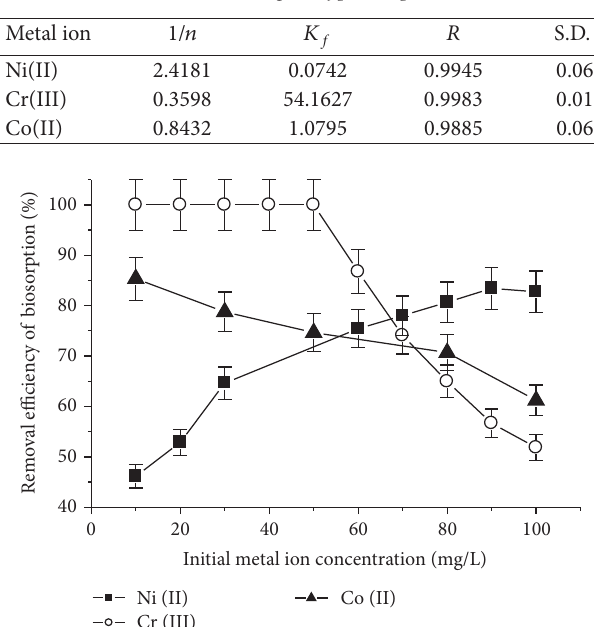
F 6: Efficiency plot for the biosorption of Ni(II), Cr(III), and Co(II) ions using Acalypha hispida leaf.